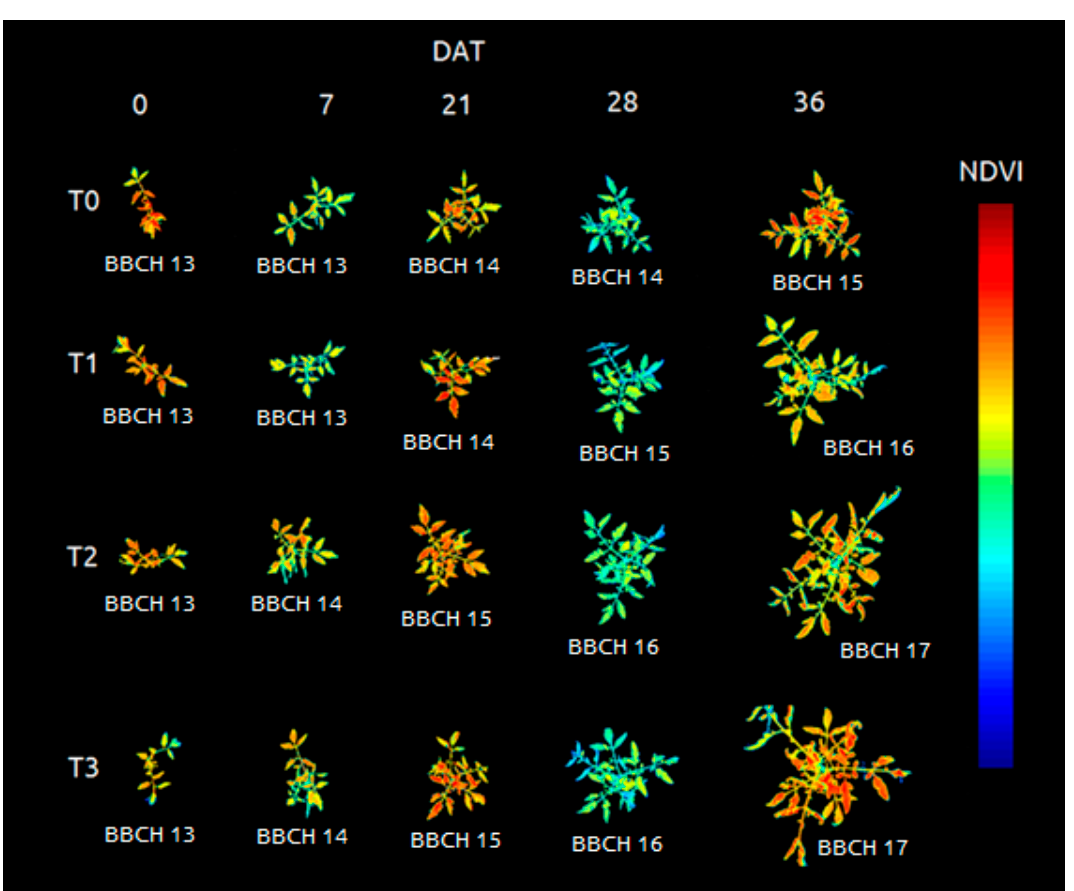
Figure 8. Evolution of the morphology and Normalized Di ff erence Vegetation Index of the tomato plants according to the fertilization treatments, the DAT (days after transplant) and the phenological state (BBCH